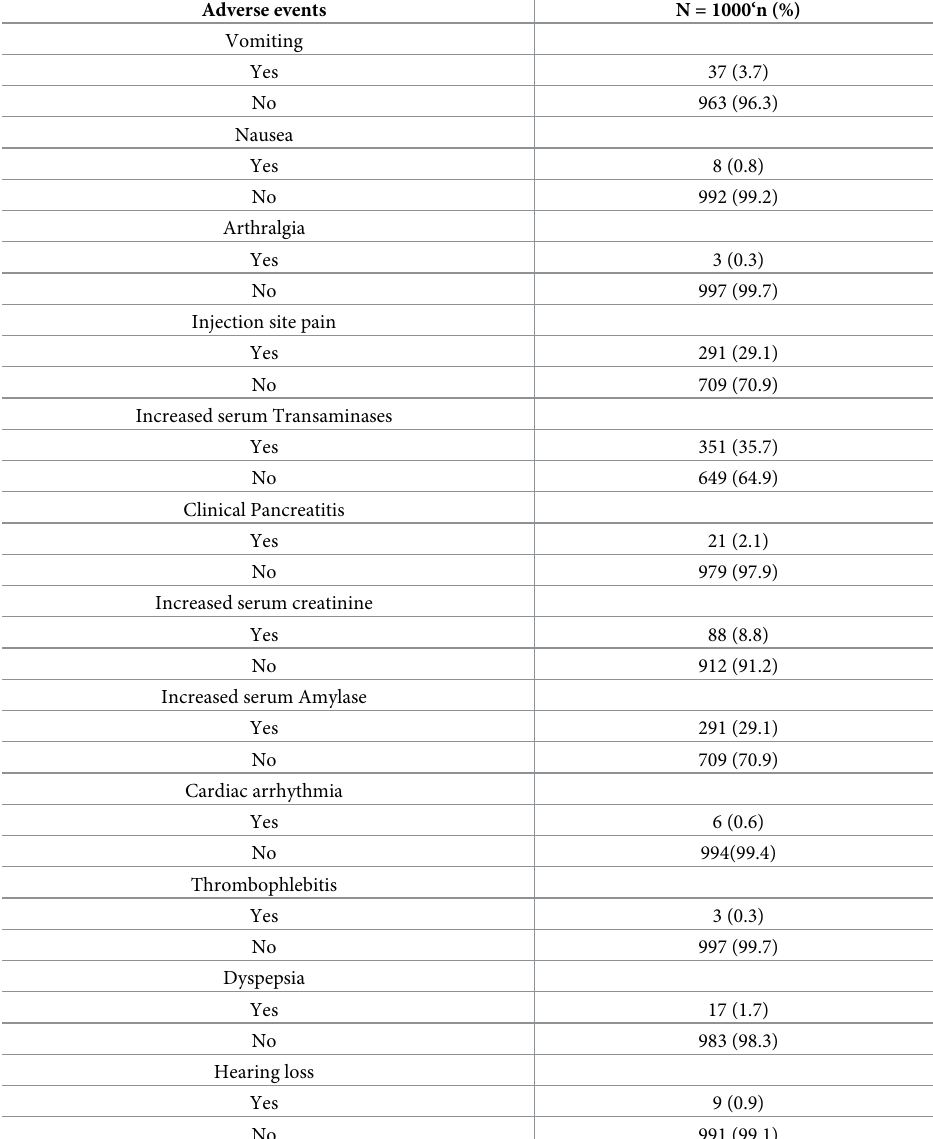
Table 3. Adverse events of VL patients treated with SSG/PM from January 1, 2012, to June 30, 2019, at UoGH-LRTC, Northwest Ethiopia (N = 1000). Adverse events N = 1000‘n